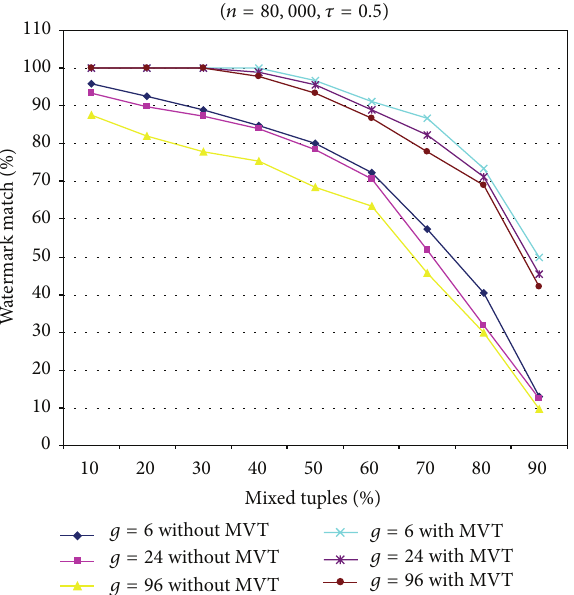
Figure 4: Relation between parameter 𝑔 and detection parameter 𝜏 of our proposed scheme with MVT in an alteration attack.